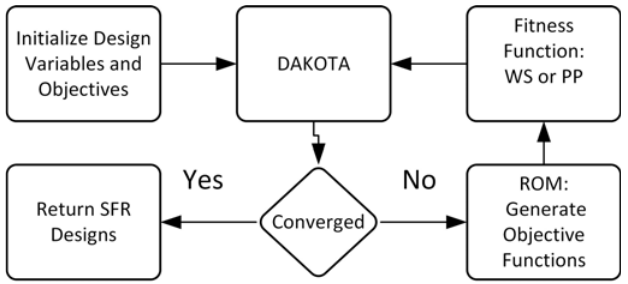
Figure 4: DAKOTA Interface for